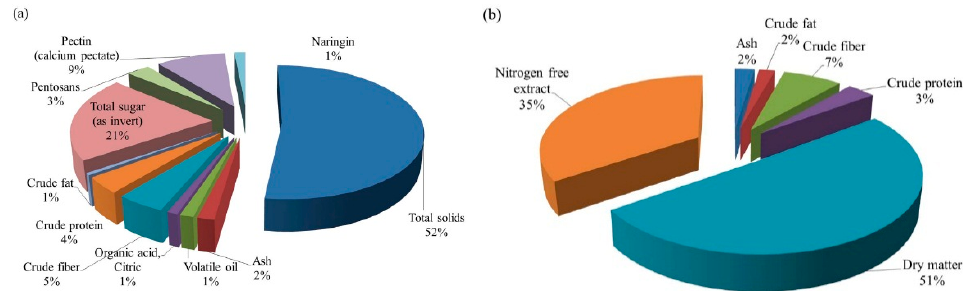
Figure 3. ( a ) The composition of typical citrus waste (peel and rag); ( b ) the composition of dried citrus pulp [9,22–27] .